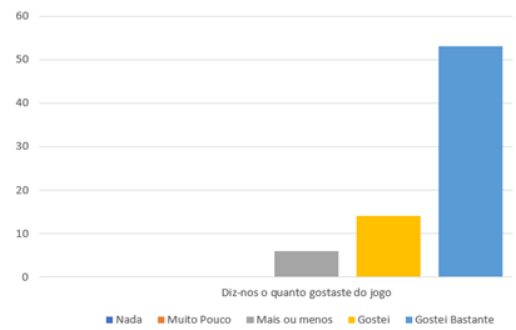
Figure 8. Students answers to the question: How much did you like the